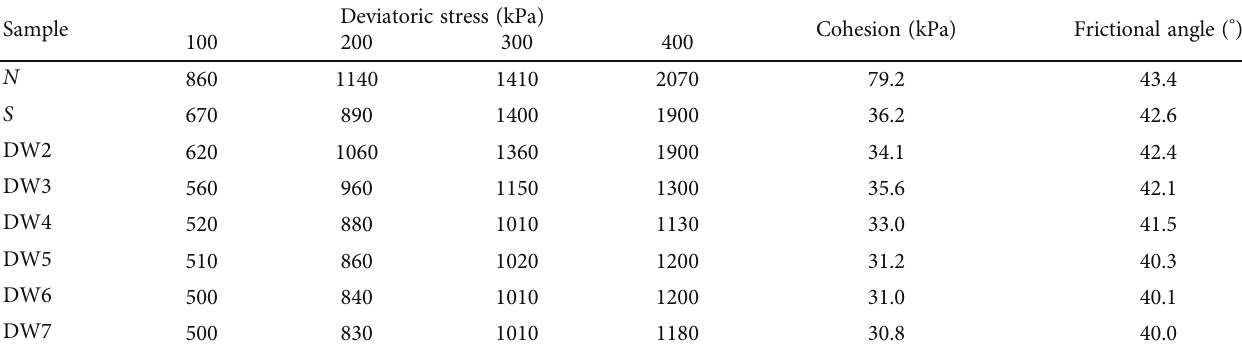
Table 3: Strength and indexes under drying – wetting